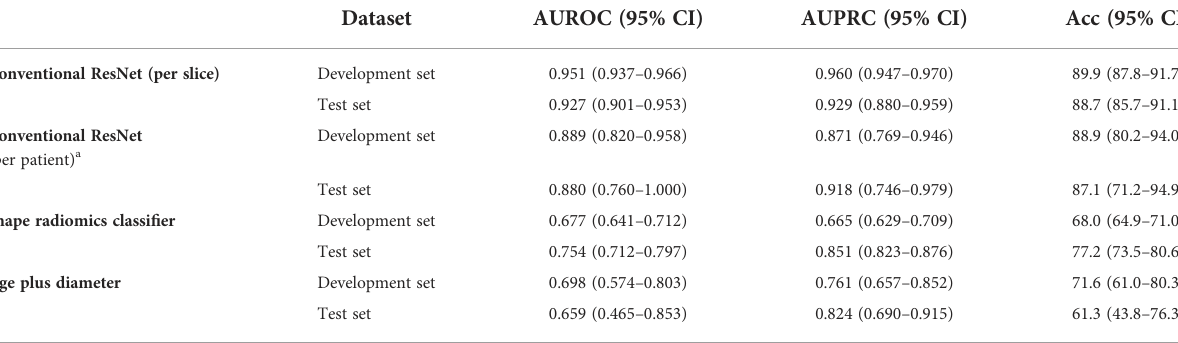
TABLE 4 Diagnostic performance of the conventional ResNet, shape radiomics classi fi er, and age plus diameter in the prediction of mitotic index.